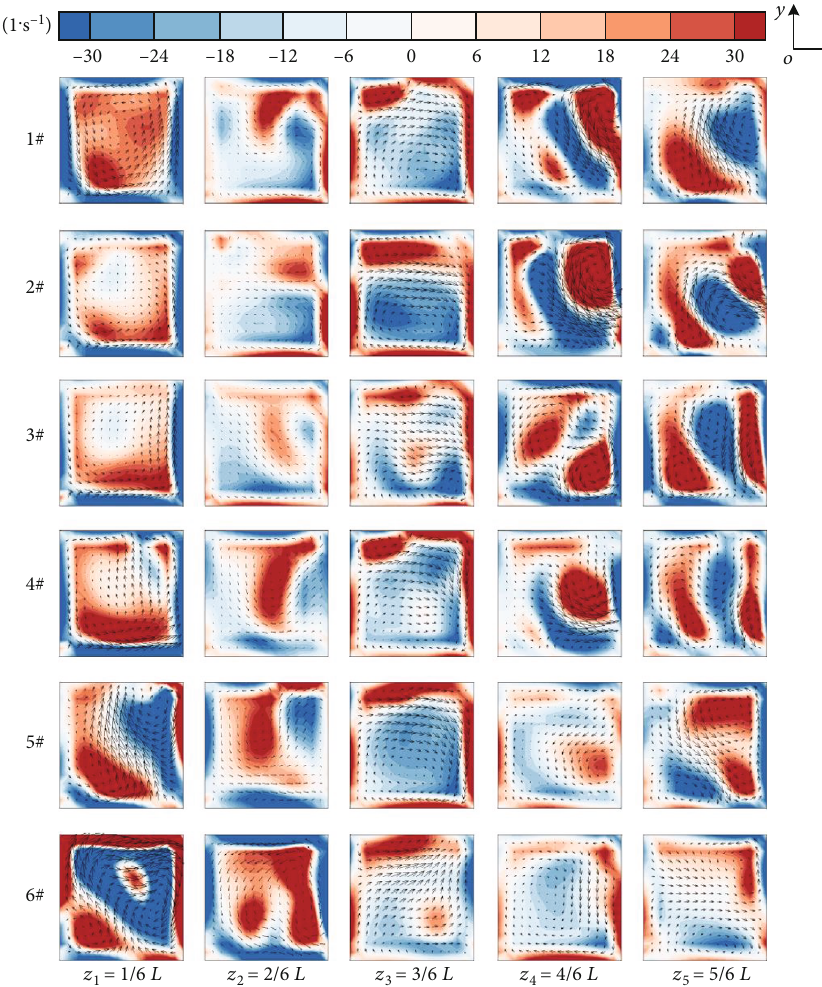
Figure 9: Instantaneous relative vorticity contours and associated relative velocity vectors in